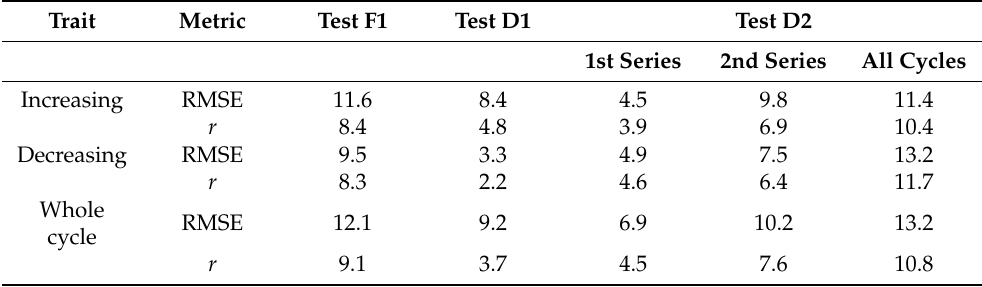
Table 2. Comparison of results obtained for the three tests by applying the proposed temperature compensation approach based on dummy sensor resistance R d . Calibration is with respect to force. Values are expressed as a percentage of the